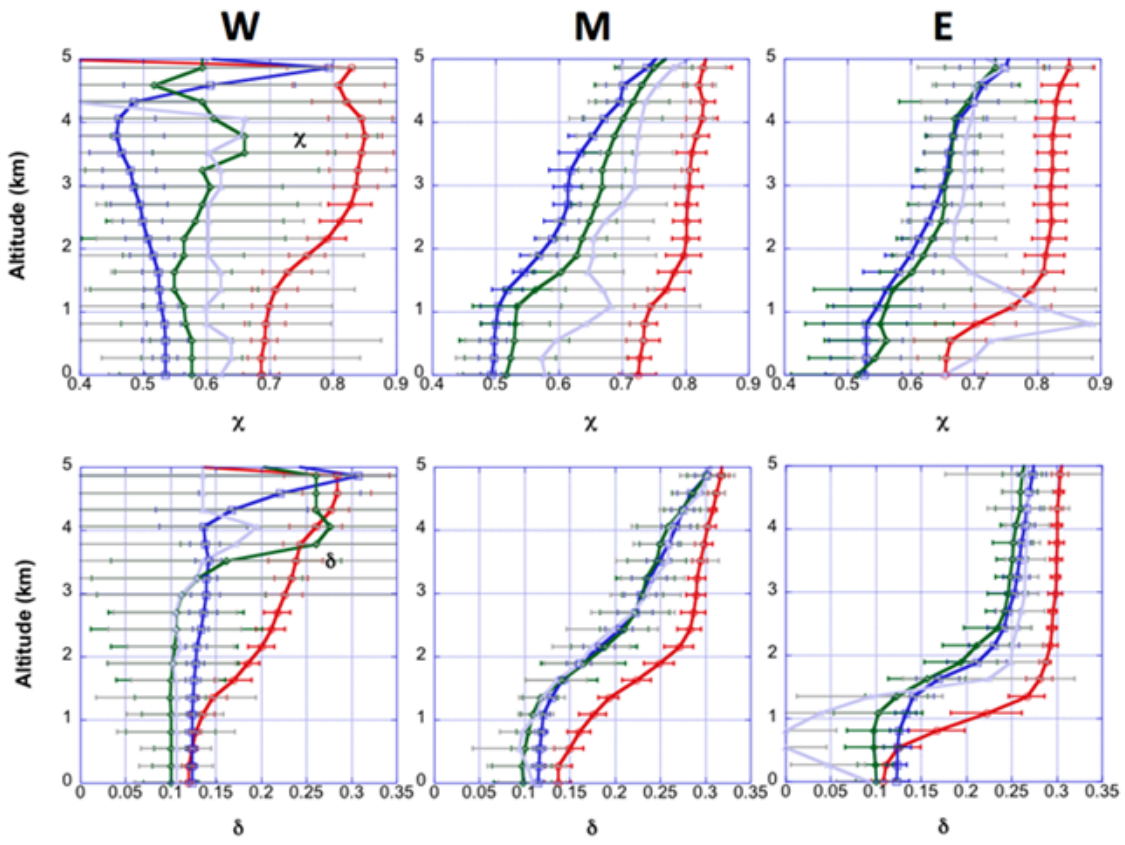
Fig. A2. Effect of cloud fraction on the vertical distribution of dust particulate color ratio (first row) and depolarization ratio (second row). These two rows correspond to the 3rd and 4th rows of Fig.